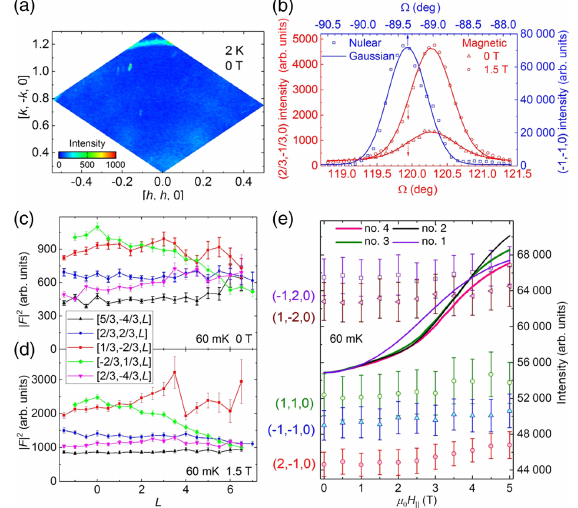
FIG. 11. (a) High-temperature neutron diffraction background measured at 2 K and 0 T on D23. The much weaker peaks are magnetic field independent at 60 mK, and should not originate from the intrinsic magnetic signal of TmMgGaO 4 . The ring- shaped signals originate from the copper sample holder. (b) Ω ; − 1 ; 0 Þ in 0 scans measured on the broad magnetic reflection ð 2 3 3 and 1.5 T applied along the c axis, as well as on the nuclear ¯1 ¯1 ; ; 0 Þ in 0 T at 60 mK on D23. The blue line shows reflection ð the Gaussian fit with the resolution of σ Ω ¼ 0 . 65 ð 2 Þ °, and the red lines are the fits to the data with a combination of the Gaussian and Lorentzian functions [see Eq. (D1)]. L dependence of selected magnetic structure factors measured on POLI in (c) 0 T and (d) 1.5 T at 60 mK. (e) Longitudinal magnetic field dependence of the integral intensities of five nuclear Bragg reflections measured at 60 mK on D23. The colored lines are the combinations of the field-independent nuclear contribution and the calculated magnetic part using different models. The scale and magnetic form factors are included in the calculated magnetic contribution [see Eq.